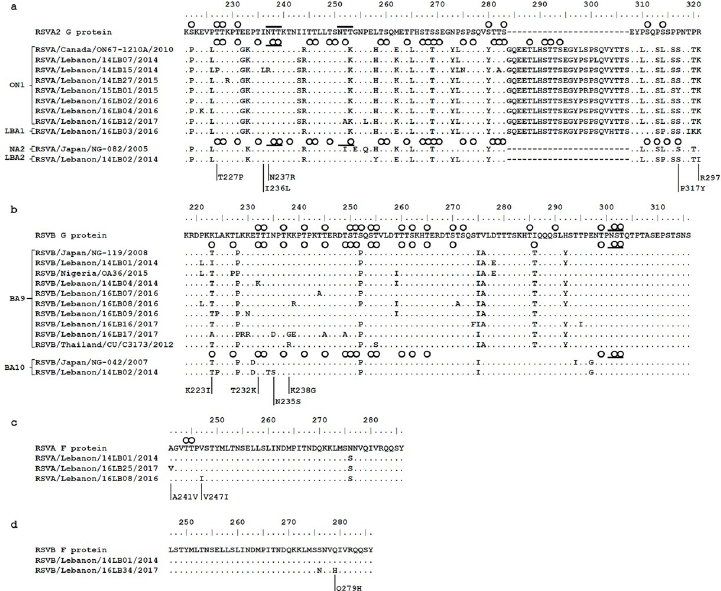
Fig 3. Amino acid sequence alignments of the G and F proteins. (a) Alignment of deduced amino acid sequences of the G protein of representative RSV-A strains relative to that of prototype strain A2 (RSVA2; M11486). A reference ON1 strain (RSVA/Canada/ON67-1210A/2010; JN257693) and a reference NA2 strain (RSVA/Japan/NG-082/2005; AB470479) were included for comparison. The alignment shown corresponds to positions 221 to 321 (297 -d ) of the second hypervariable region of RSV-A A2 strain G protein. (b) Alignment of deduced amino acid sequences of the G protein of representative RSV-B strains relative to that of the prototype BA4128/99B (RSVB; AY333364). A reference BA9 strain (RSVB/Nigeria/OA36/2015; HM459878) and a reference BA10 strain (RSVB/Japan/NG-042/2007; HM459884) were included for comparison. The alignment shown corresponds to positions 218 to 316 of the second hypervariable region of RSV-B strain BA4128/99B G protein. (c) Alignment of deduced amino acid sequences of the F protein of representative RSV-A strains relative to that of a prototype reference (RSVA/Australia/A2/1961; KJ155694). The alignment shown corresponds to positions 241 to 286 of the F protein. (d) Alignment of deduced amino acid sequences of the F protein of representative RSV-B strains relative to that of a prototype reference (D00334). The alignment shown corresponds to positions 247 to 286 of the F protein. Identical residues are identified as dots. Asn- Xaa-Ser/Thr sequons predicted to be N-glycosylated are highlighted with a line. Serine and threonine residues predicted to be O-glycosylated are highlighted with a circle. Unique amino acid substitutions are indicated.